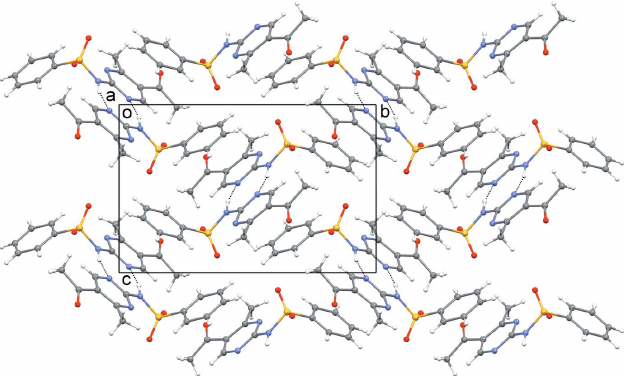
Figure 2 Crystal packing viewed down the a axis with N—H (cid:2)(cid:2)(cid:2) N hydrogen bonds shown as dotted lines.